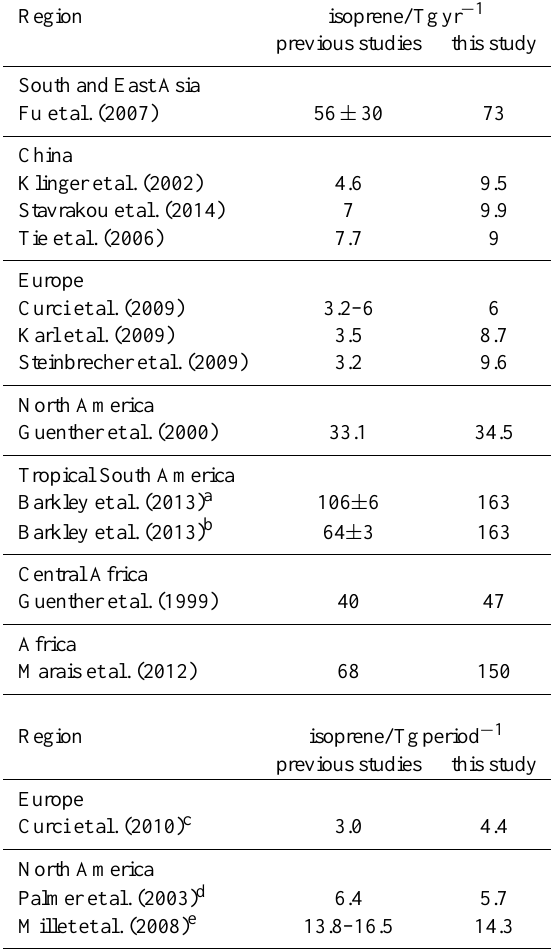
Table 3. Comparison of isoprene emission totals from regional stud- ies (left) and MEGAN–MACC (right). MEGAN–MACC emissions were extracted for the particular region and period of the regional